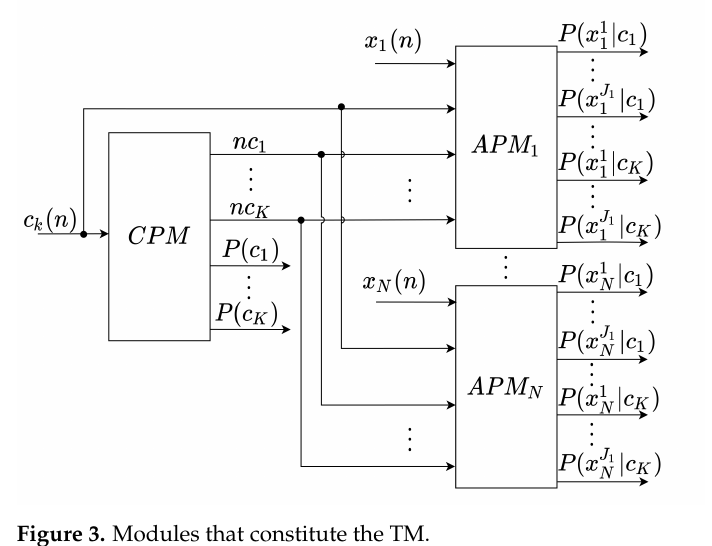
Figure 3. Modules that constitute the TM.